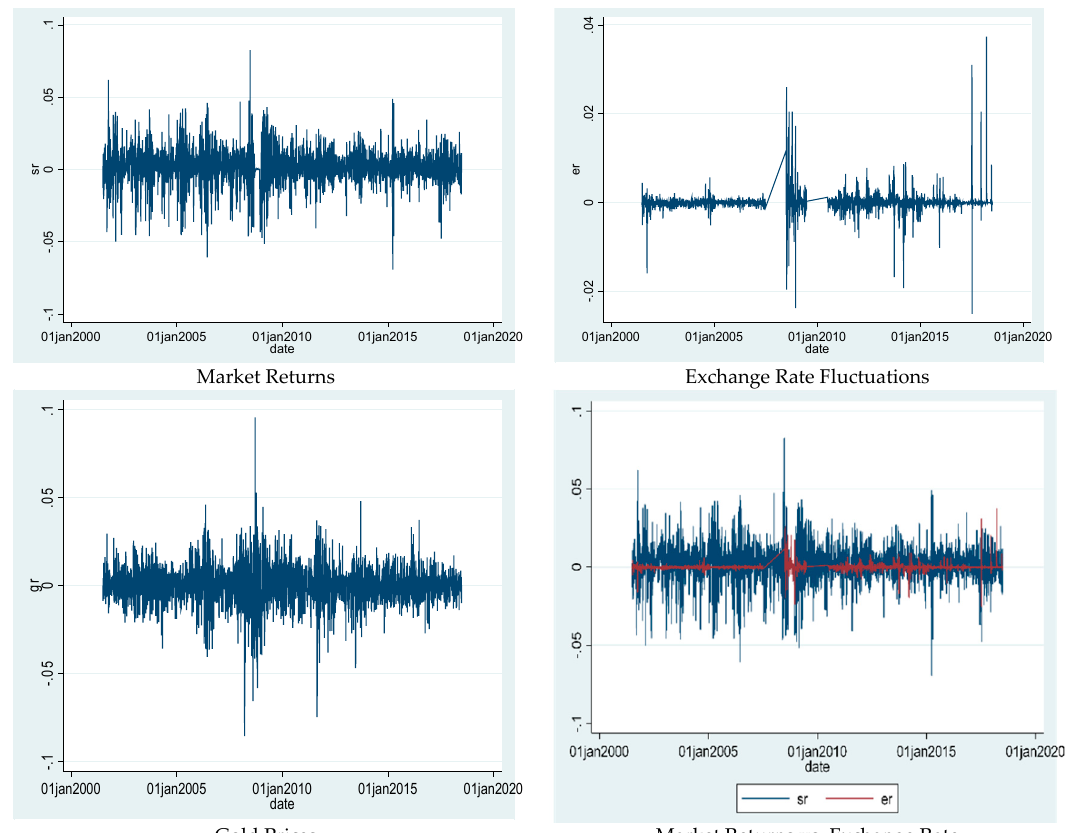
Figure 1. Market returns, exchange rate, gold price, and market return with exchange rate.